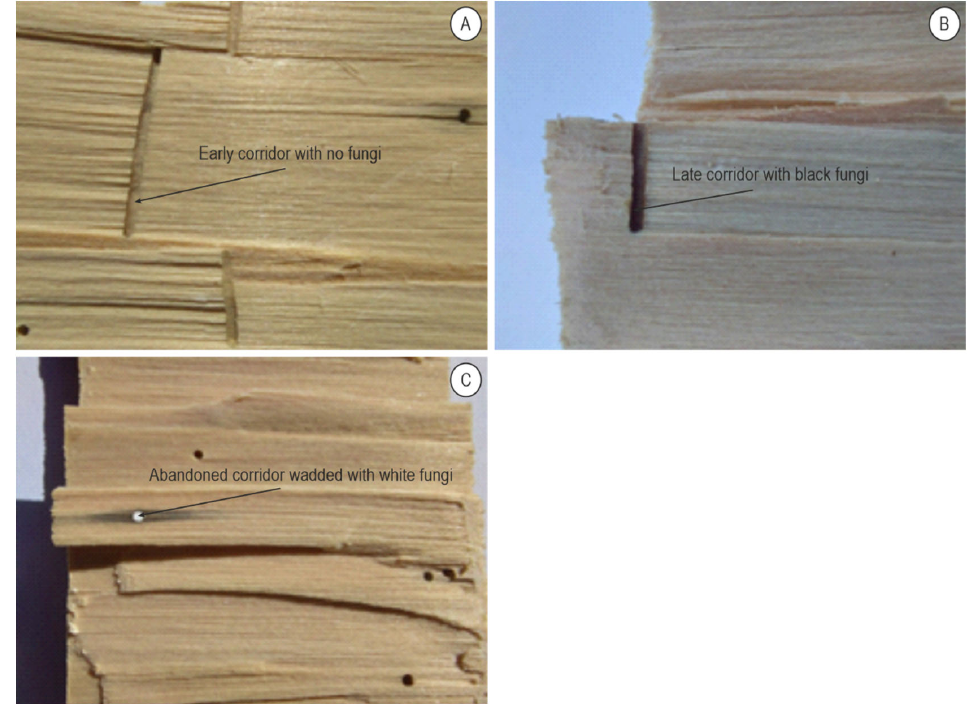
Figure 5. Stages of corridor development and fungus development: ( A ) early; ( B ) late; and ( C ) abandoned corridor.